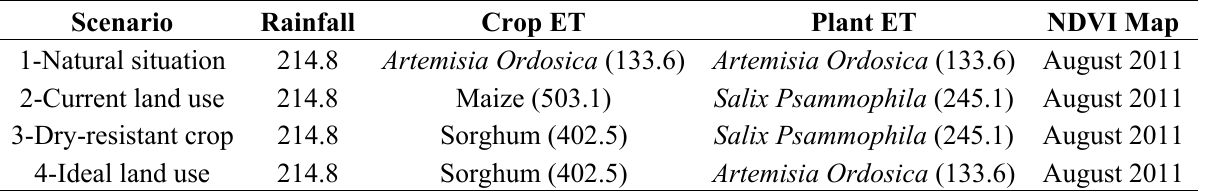
Table 1. ET values for reference crops and plants for scenario simulations (mm/year).